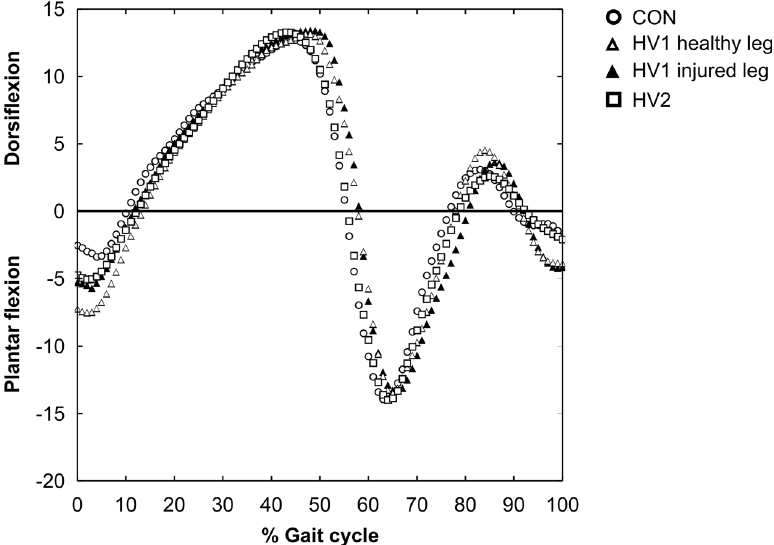
Fig.4 Ankle plantar/dorsi flexion angular position (in deg) during the gait cycle 3.1 Subjects with both-sided JHV The following statistical differences are compared to the control group. The subjects demonstrated a greater range of motion (ROM) in the frontal plane during the pelvis drop and rise (p < 0.01) (Fig. 5), and a tendency to a decreased lower extremity abduction angular position during the gait cycle (p < 0.01) (Fig. 6). As the individuals stabilized their body weight at loading response their peak ankle plantar flexion was greater (p < 0.01) (Fig. 7). Additionally, the subjects experienced smaller peak hip extension (p < 0.05) at terminal stance (Fig. 8). When the foot advanced from its trailing position to a swing phase the peak knee flexion increased its angular value (p < 0.01) at initial swing (Fig. 9), and the peak hip flexion showed the statistical difference (p < 0.01) at terminal swing (Fig. 10).